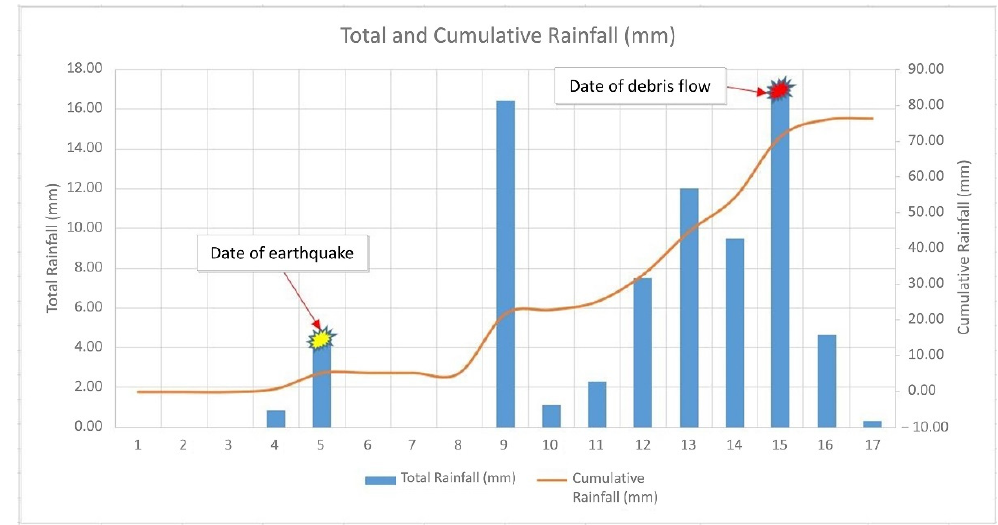
Figure 3. The recorded total rainfall (daily) and cumulative rainfall between earthquake and debris flow events, retrieved from Malaysia Meteorological Department (MMD).